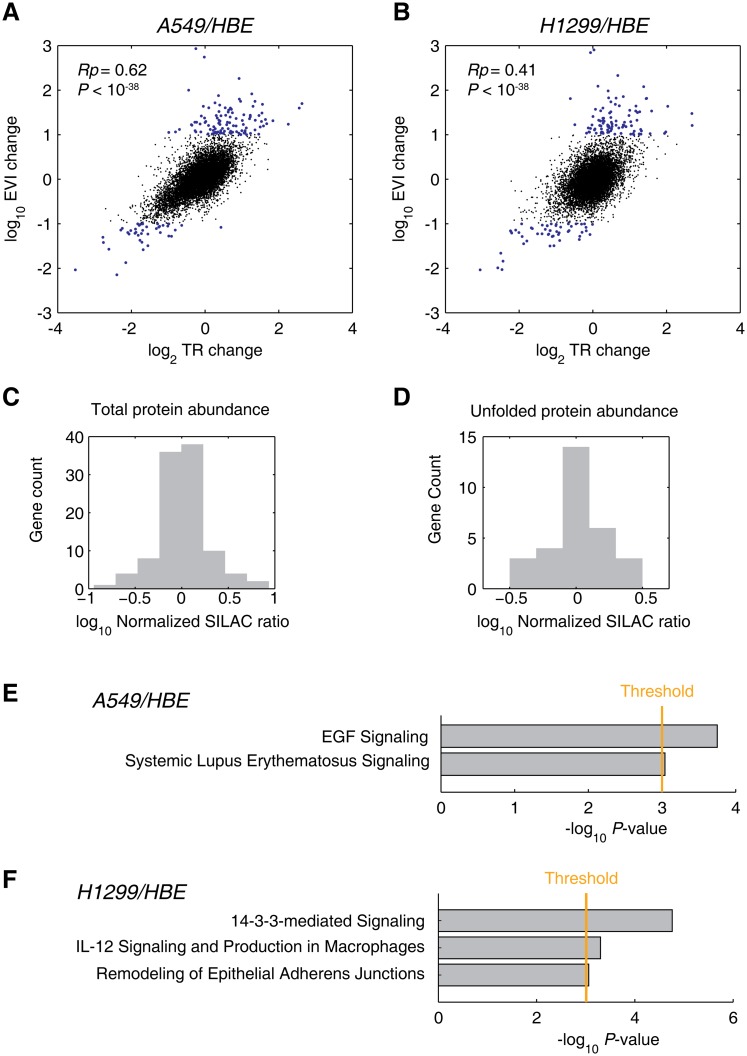
Relative EVI analysis and cancer relevance.(A, B) Correlation of the relative changes of TR and EVI comparing cancer with normal cells. A549/HBE (A) and H1299/HBE (B) results were shown, respectively; the genes with relative EVIs of greater than ±10 folds were indicated by blue dots. (C,D) Comparative proteomics analyses on the low-EVI genes comparing A549 cells with HBE cells. Relative abundance distributions of total proteins (C) and the unfolded proteins (D) are shown. (E, F) Top canonical pathway analysis of low relative EVIs by IPA. Low relative EVI genes (<10 folds) in A549/HBE (E) and H1299/HBE (F) comparisons were subjected to IPA analysis. The top canonical pathways with P < 0.001 (Fisher’s exact test provided by IPA indicated by the threshold line in orange) regulated by of these genes were shown respectively. The complete gene lists for IPA are included in the S2 Table with HGNC gene names.